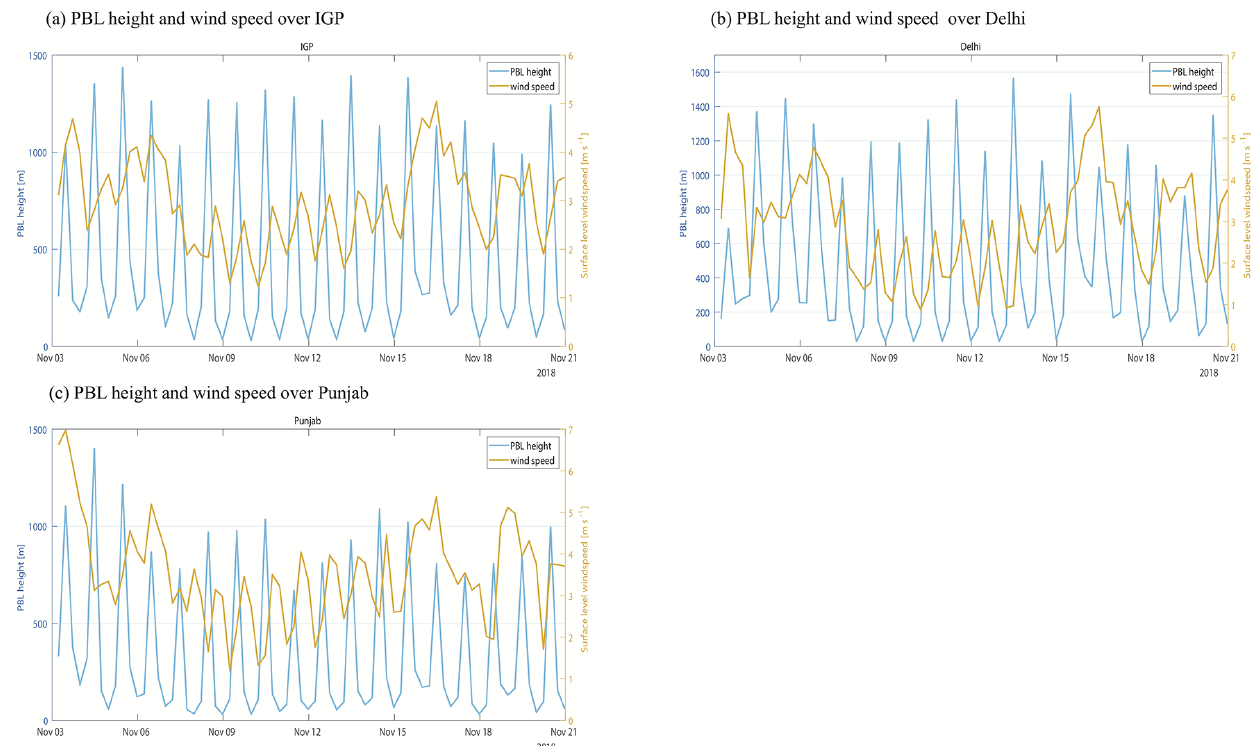
Figure 9. PBL height and surface-level wind speed from WRF model simulations for a period of 3–20 November 2018 over (a) the IGP region, (b) Delhi, and (c)